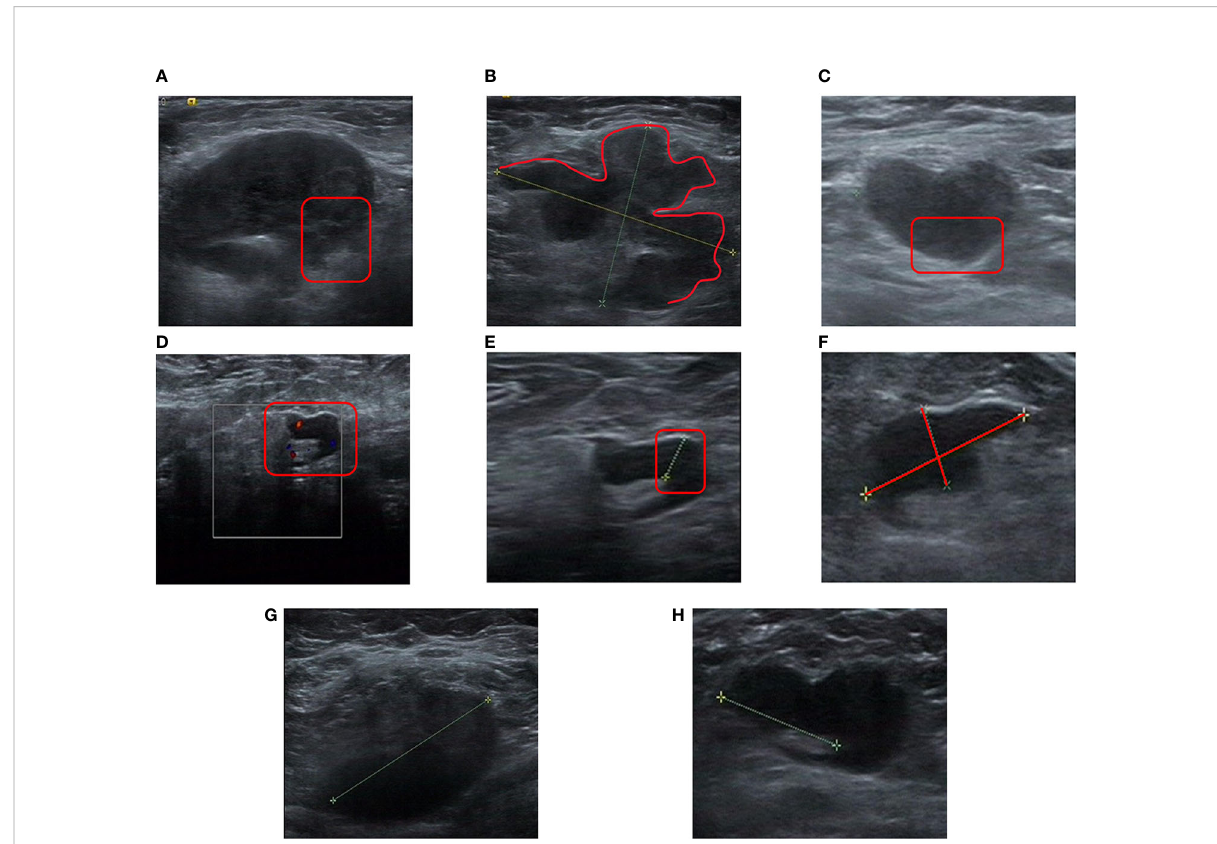
FIGURE 2 Speci fi c image features for a lymph node score. (A) , Unclear border (As shown in the red box, the border of the lymph node is unclear from the surrounding tissue). (B) , Irregular morphology (as shown in the red line, the loss of an elliptical shape led to a lobulated shape). (C) , Absence of hilum (the lymph nodes shown in the red boxes were almost all hypoechoic, and no echo of the hilum was seen). (D) , Visible vascularity (vascularity is visible in the cortex and hilum shown in the box). (E) , Cortical thickness (signi fi cant cortical thickness shown in the red box). (F) , Aspect ratio <2 (ratio of vertical axis to horizontal axis <2). (G) , Unclear border, irregular morphology, absence of hilum, cortical thickness (LNS = 4 points). (H) , Unclear border, irregular morphology, cortical thickness (LNS = 3 points). LNS, lymph node